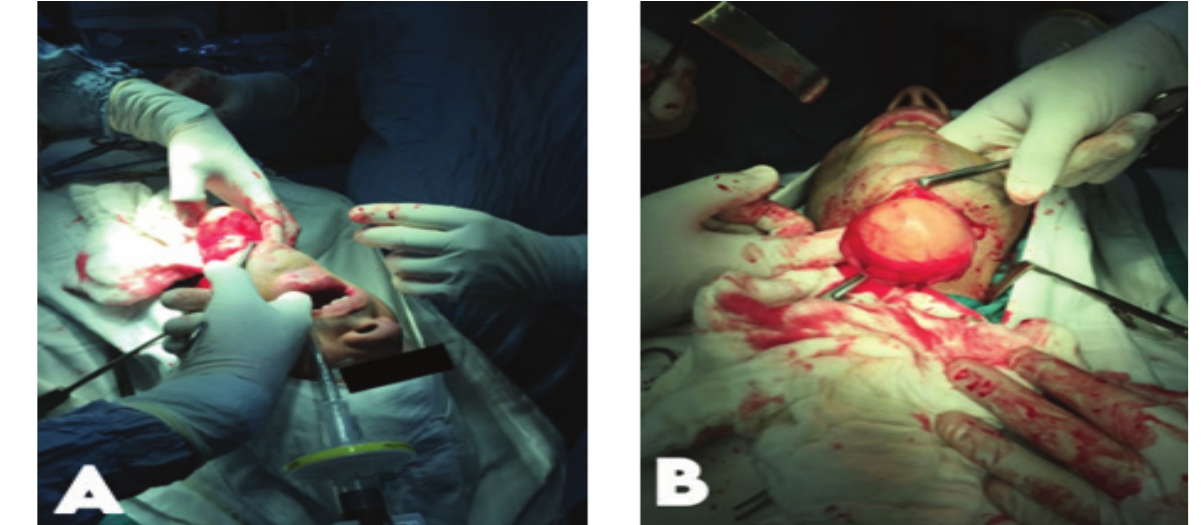
Figure-II: Pre-Operative Views (A) Superior view (B) frontal view.